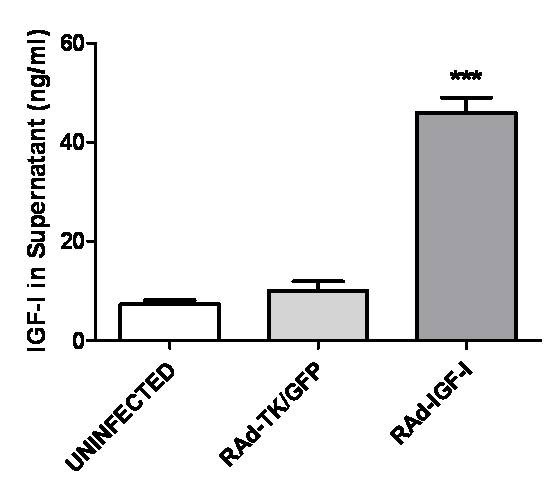
RAd-IGF-I increases release of IGF-I by astrocytes. Levels of IGF-I in the culture medium of astrocytes incubated for 24 h with medium alone (uninfected cells), RAd-TK/GFP or RAd-IGF-I. Total IGF-I was assayed in supernatants and the peptide concentration referred to the original volume of medium per well. Bars on columns represent mean ± SEM, (n = 4). ***, Significant difference (P < 0.001) versus the values of the other two experimental groups.